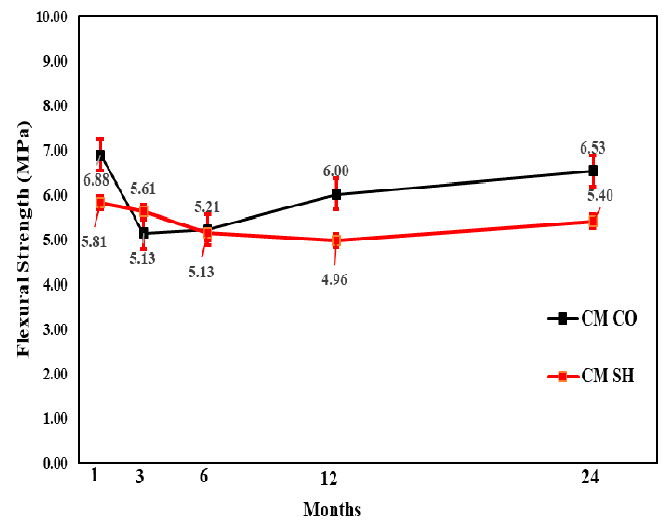
Figure 17. CM accelerator mix flexural strength by age.